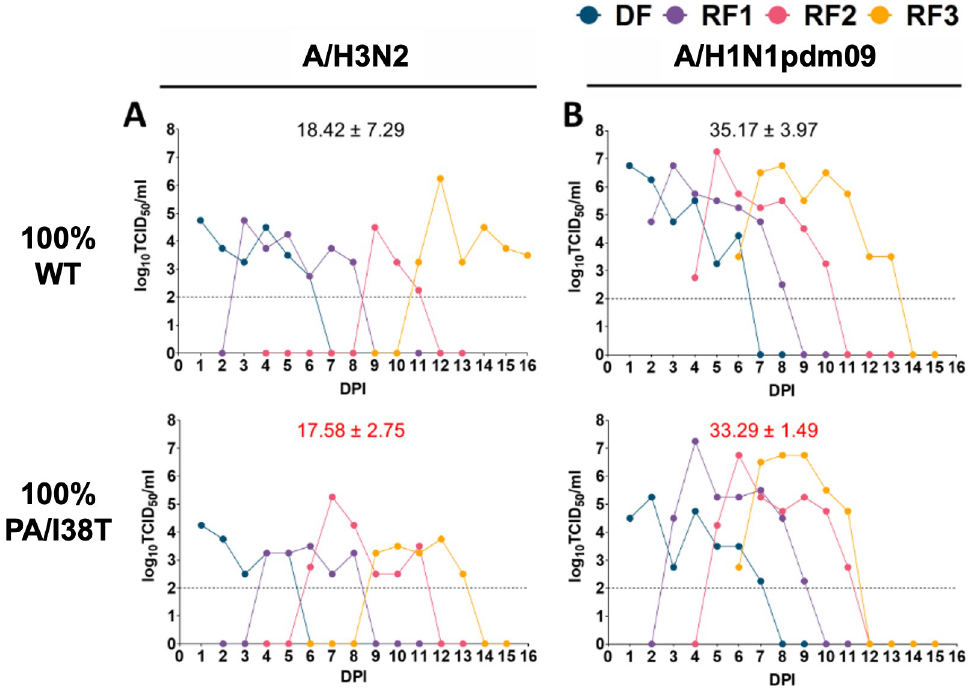
Fig 3. Infectious viral titers (TCID 50 ) in nasal washes of direct contact recipient ferrets 1–3 (RF1-RF3) from pure (100%) WT and pure PA/I38T infection groups. (A) A/H3N2 clinical isolates; (B) A/H1N1pdm09 clinical isolates. Virus replication kinetics (TCID 50 ) in ferrets infected by direct contact transmission (DF and RF1-RF3) using pure populations of WT or PA/I38T-variant virus for (A) A/H3N2 or (B) A/H1N1pdm09 subtypes. Points represent infectious titers (log 10 TCID 50 /mL) in individual ferret nasal washes from each DPI of DF. The mean AUC of infectious virus shedding (AUC TCID 50 ± SD) for RF1-RF3 in each group is labelled (black text, WT; red text, PA/I38T). AUC, area under the curve; DF, donor ferret; DPI, days post inoculation; RF, recipient ferret; SD, standard deviation; TCID 50 , 50% tissue culture infectious dose; WT, wild